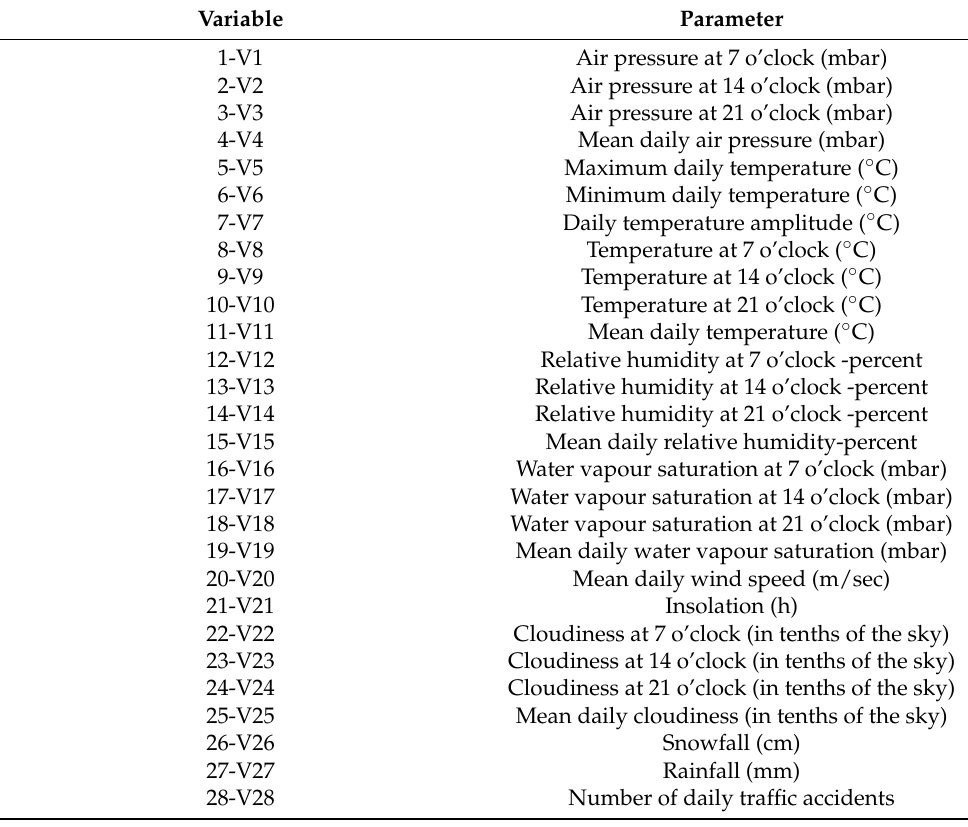
Table 2. Atmospheric parameters used in case